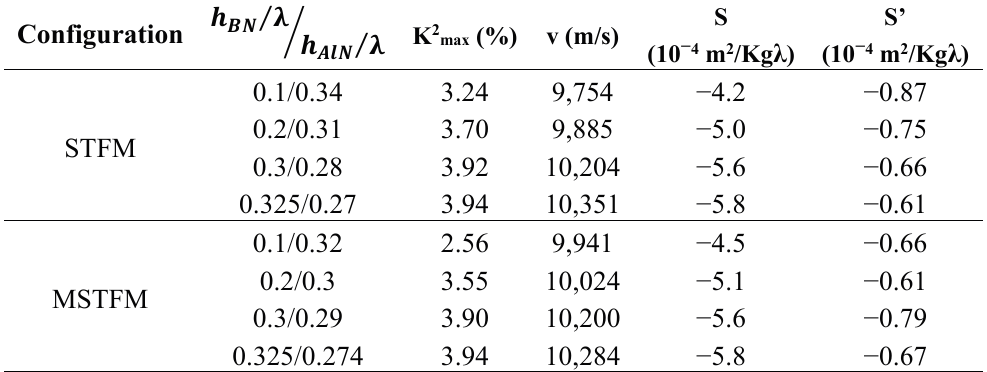
Table 2. The maximum K 2 value obtainable with the most efficient coupling structures, STFM and MSTFM, is listed together with the corresponding phase velocity and mass loading sensitivities, S and S’, evaluated with respect to the AlN and BN